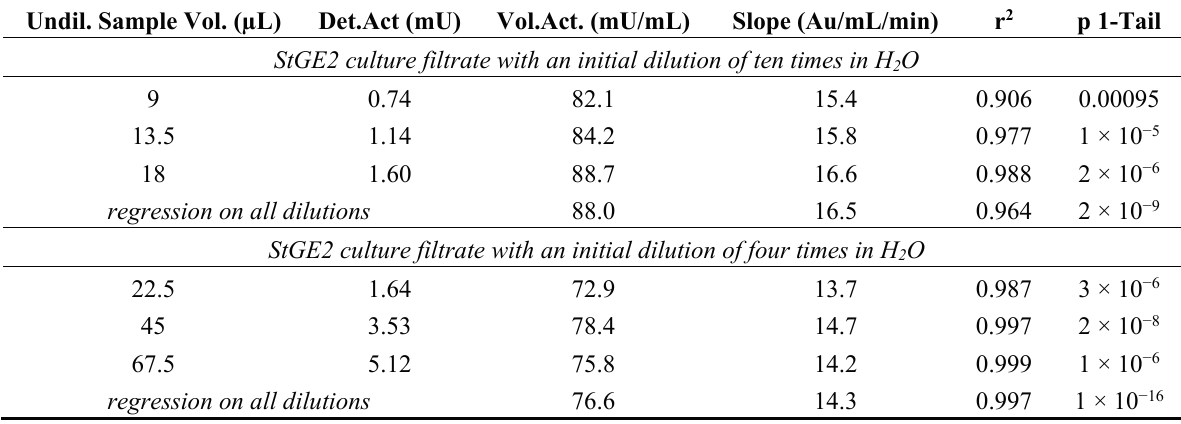
Table 1. Results from the spectrophotometric assay for an St GE2 culture filtrate for two separate dilution series. Sample volume in the first column refers to the volume of undiluted culture filtrate. Activity is calculated ( i ) separately for each dilution and ( ii ) for each series as a regression on all dilutions. For each sample, the determined activity (Det.Act.) and the volumetric activity (Vol.Act.; based on the undiluted sample) are presented. The coefficient of determination (r 2 ) and the 1-tailed significance for each slope (p) are given. The analysis is also outlined in Figure